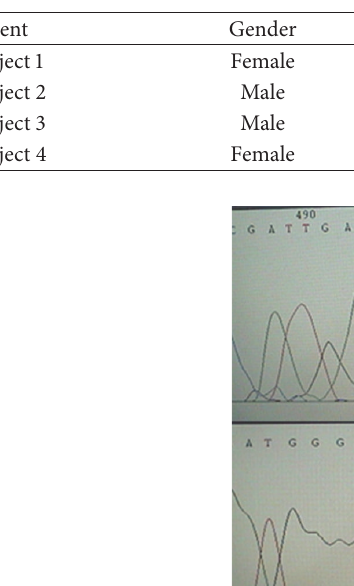
Table 2: Patient’s characteristics with the A8027G polymorphism.